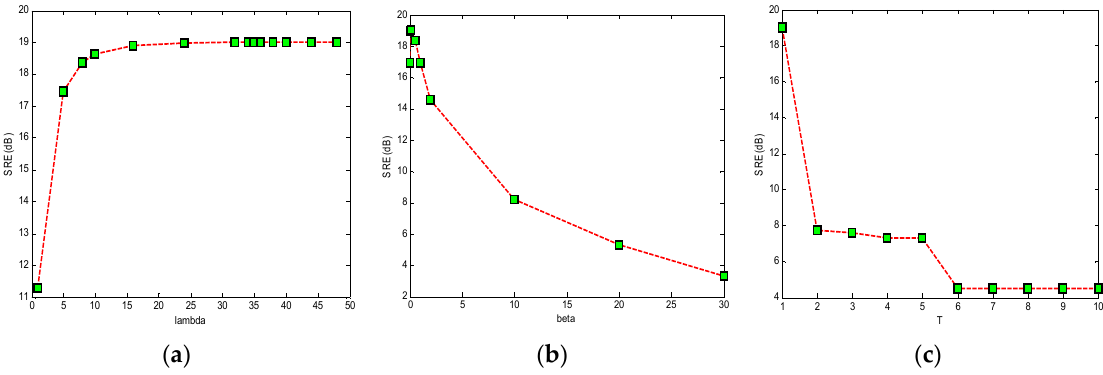
Figure 10. SRE in relation to lambda ( a ), beta ( b ) and T ( c ) for DC2 with SNR = 30 dB. Tables 2 and 4 show the computation time costs for the different algorithms on DC1 and